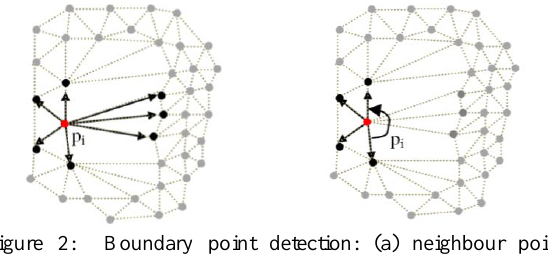
Figure 2: Boundary point detection: (a) neighbour point distribution of the edge point P i (points indicating arrows) with TNN neighbourhood; and (b) after removing long TIN